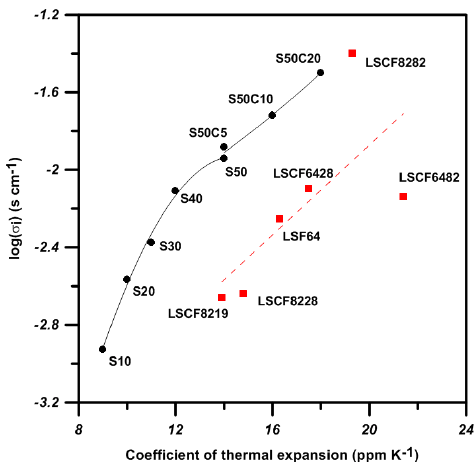
Figure 3. Ionic conductivity at 800 °C of (Bi,Sr)FeO 3 and (Bi,Sr)(CoFe)O 3 plotted against CTE (room to 800 °C) and the data (dot line) of La-perovskites [11]. Note the numbers following LSCF are the proportion of the La, Sr, Co, Fe elements.